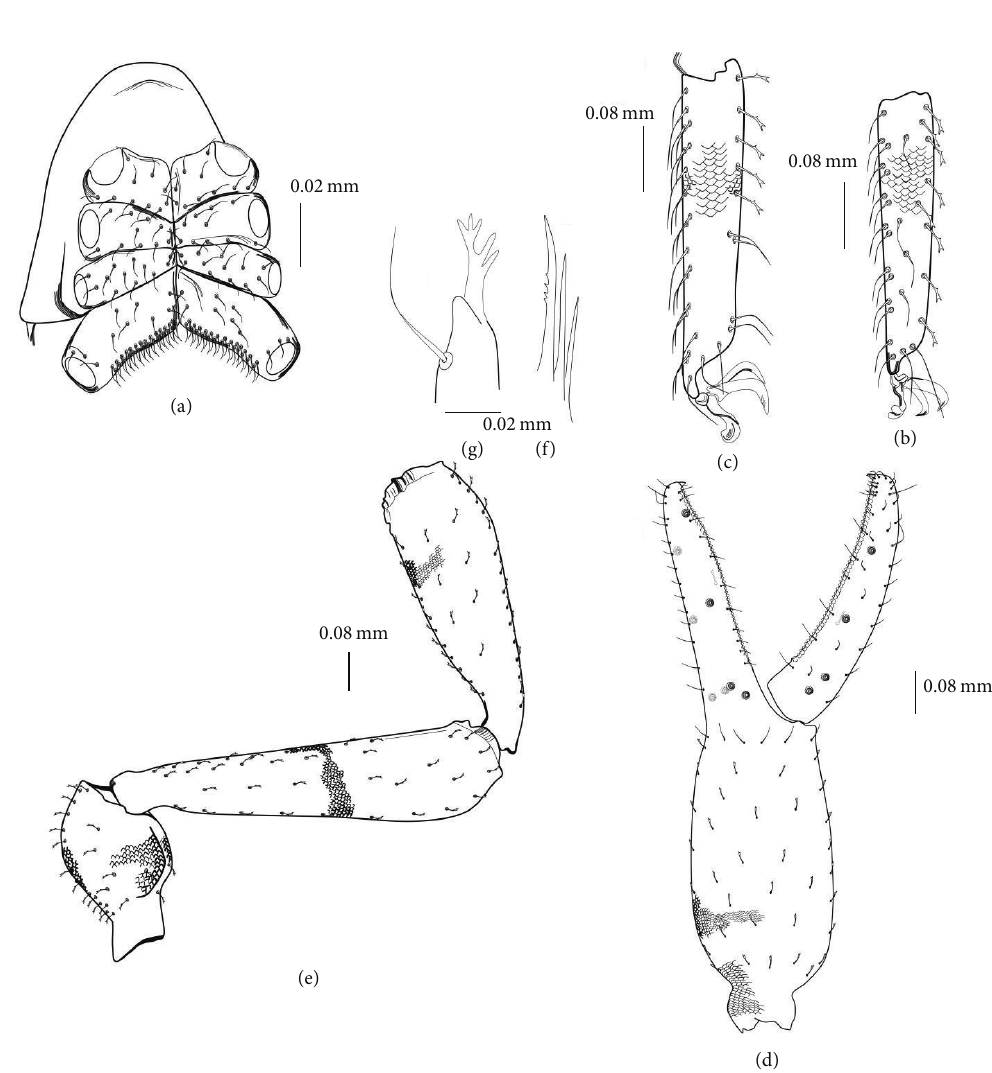
Figure 6: Female: (a) ventral side of carapace, (b) tarsus of leg I, (c) tarsus of leg IV, (d) right chela, (e) pedipalp, (f) rallum, and (g)